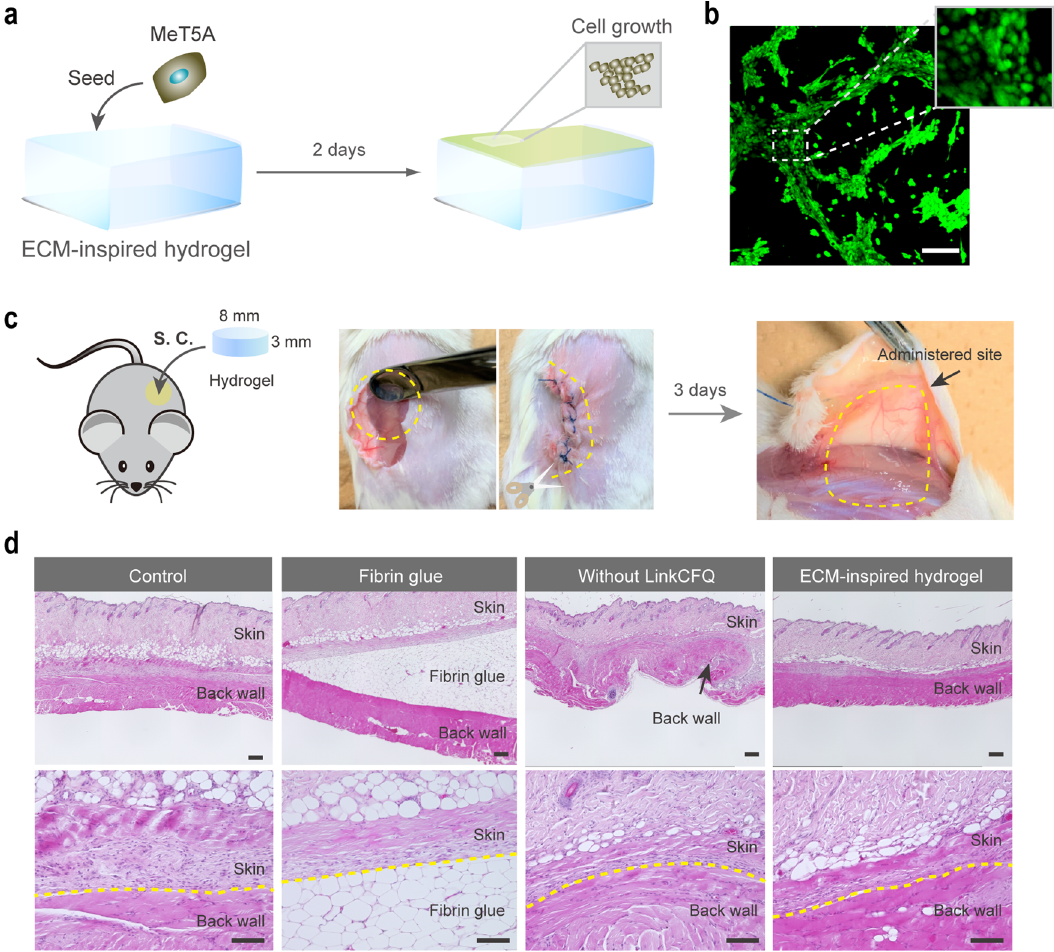
Fig. 6 Evaluation of the biocompatibility of the fabricated ECM-inspired hydrogel. a Schematic illustration of the effect of the ECM-inspired hydrogel on cultured cells. b Confocal laser microscopic observation of cells cultured on the fabricated ECM-inspired hydrogel. Live cells were stained with Calcein acetoxymethyl ester (Calcein-AM; green). Scale bar, 100 μ m ( N = 2). c Schematic illustration of the subcutaneous administration of ECM-inspired hydrogel into mice. The administration site was evaluated 3 days after the administration. d Hematoxylin − eosin staining of the skin tissue of mice administered with fi brin glue, hydrogel without LinkCFQ, and ECM-inspired hydrogel. Mice that received no material were used as the control. Scale bar: 200 μ m (upper image) and 100 μ m (lower image; N =